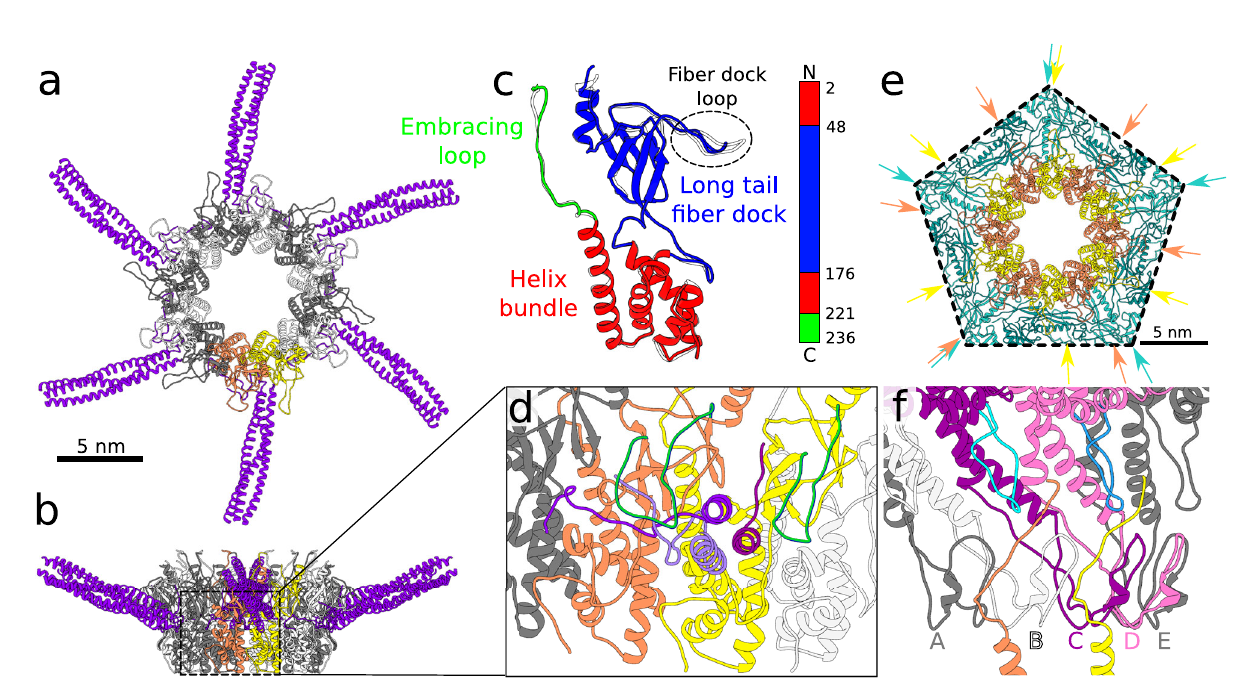
Fig. 5 | Adaptor complex and its interactions with long tail fi bers, portal, and capsid.a , b Cartoonrepresentationofadaptorcomplexdecoratedwithsixlongtail fi bers viewed along and perpendicular to tail axis. Two selected adaptor proteins from the dodecamerare highlighted inorange and yellow. The remaining subunits areshowninalternatingwhiteandgrey.Eachofthesixlongtail fi bersisformedbya trimer of gp12 proteins (violet). c Superposition of structures of two neighboring adaptor proteins that differ in the conformation of their long tail fi ber dock loops. One of the adaptor proteins is colored according to the domain composition. The superimposed subunit is shown in white. The domain organization of adaptor proteinisshownasa1Dplot. d Interactionsofadaptorproteinswithlongtail fi ber. Fiber dock loops (green) of two neighboring adaptor proteins interact with one long tail fi ber. The three subunits that form the long tail fi ber are differentiated by shades of violet. The N-terminus of each long tail fi ber protein from one long tail fi berformsuniqueinteractionswiththeadaptorcomplex. e Interactionsofadaptor complex with capsid viewed along tail axis from outside the particle. Adaptor